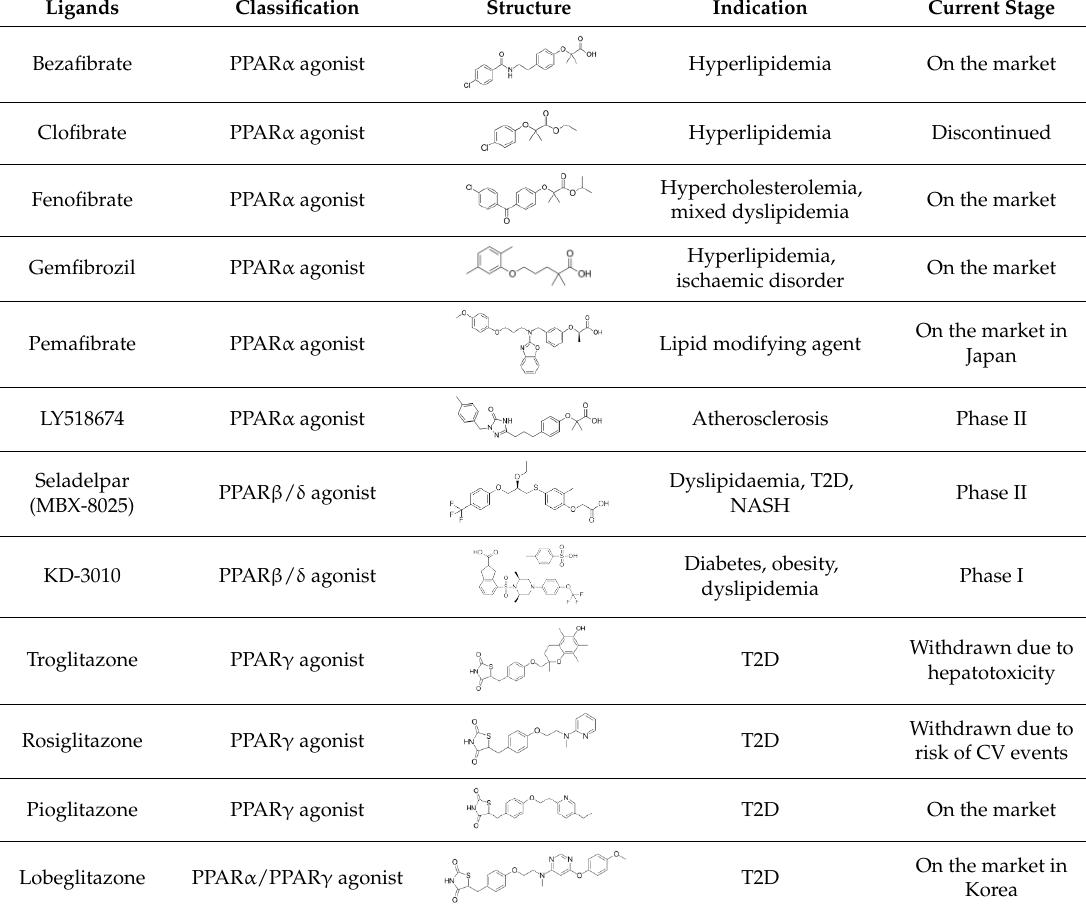
Table 1. Different PPAR ligands and their development status regarding the treatment of lipid and glucose metabolic syndrome.